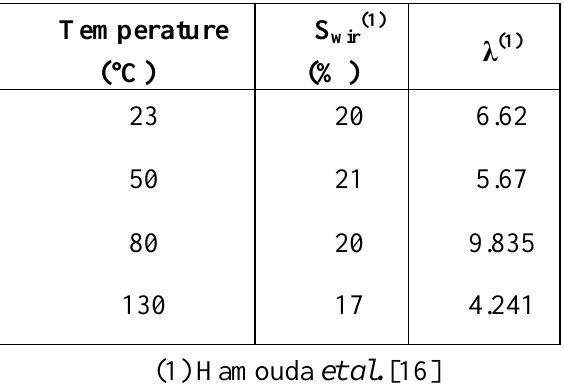
Table 1. S and λ for experimental relative permeability wir